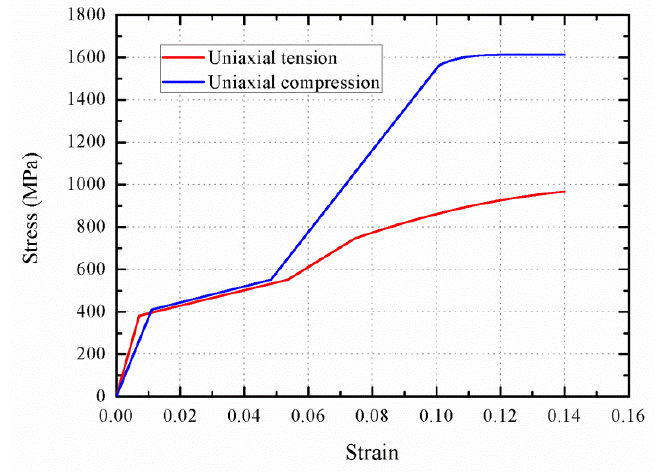
Figure 14. The stress – strain response with various loading directions.